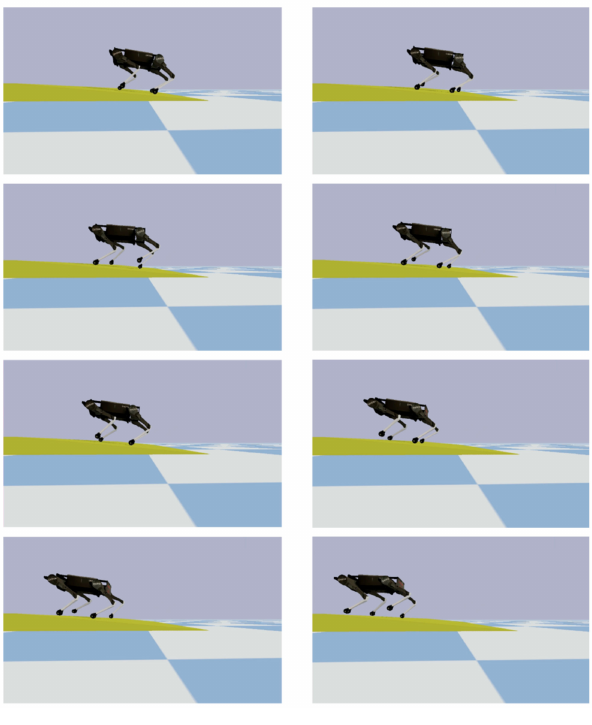
Figure 14. Robot moving on a slope.